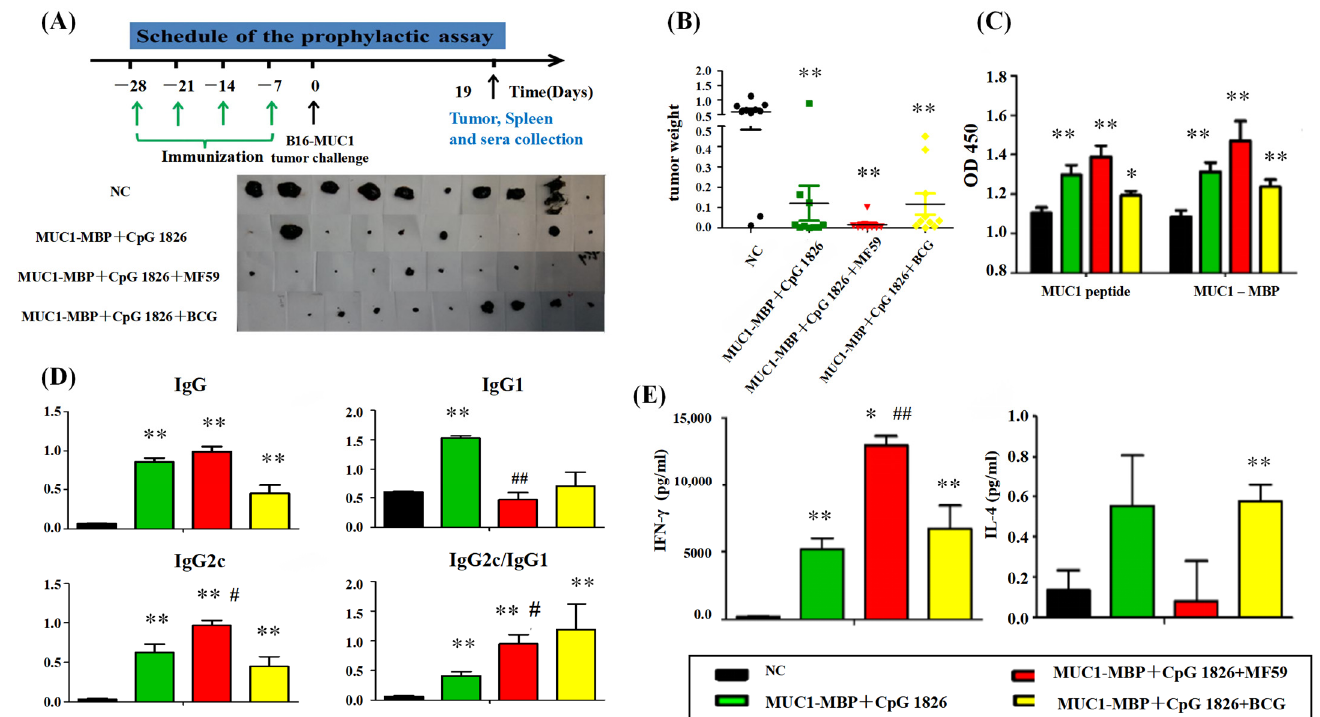
Figure 2. MF59 promotes the antimelanoma effect induced by M-M/CpG 1826. The mice were immunized with M-M/CpG 1826, M-M/CpG 1826/MF59, M-M/CpG 1826/BCG and PBS four times. One week after the final immunization, the mice were challenged with a subcutaneous injection (s.c.) with 5 × 10 5 /mouse B16-MUC1 cells to build a tumor-bearing model. ( A – C ) The immunization protocol in the prophylactic melanoma tumor model. The tumor and tumor weight in each vaccine formulation. Mice were sacrificed on Day 19, and tumors were harvested for weighing ( n = 10). Effects of M-M combined with different adjuvants on lymphocyte proliferation ( D ) and cytokines ( E ) secreted by mouse spleen cells. * p < 0.05, ** p < 0.01 vs. NC group. # p < 0.05, ## p <0.01 vs. the M-M/CpG 1826 group.